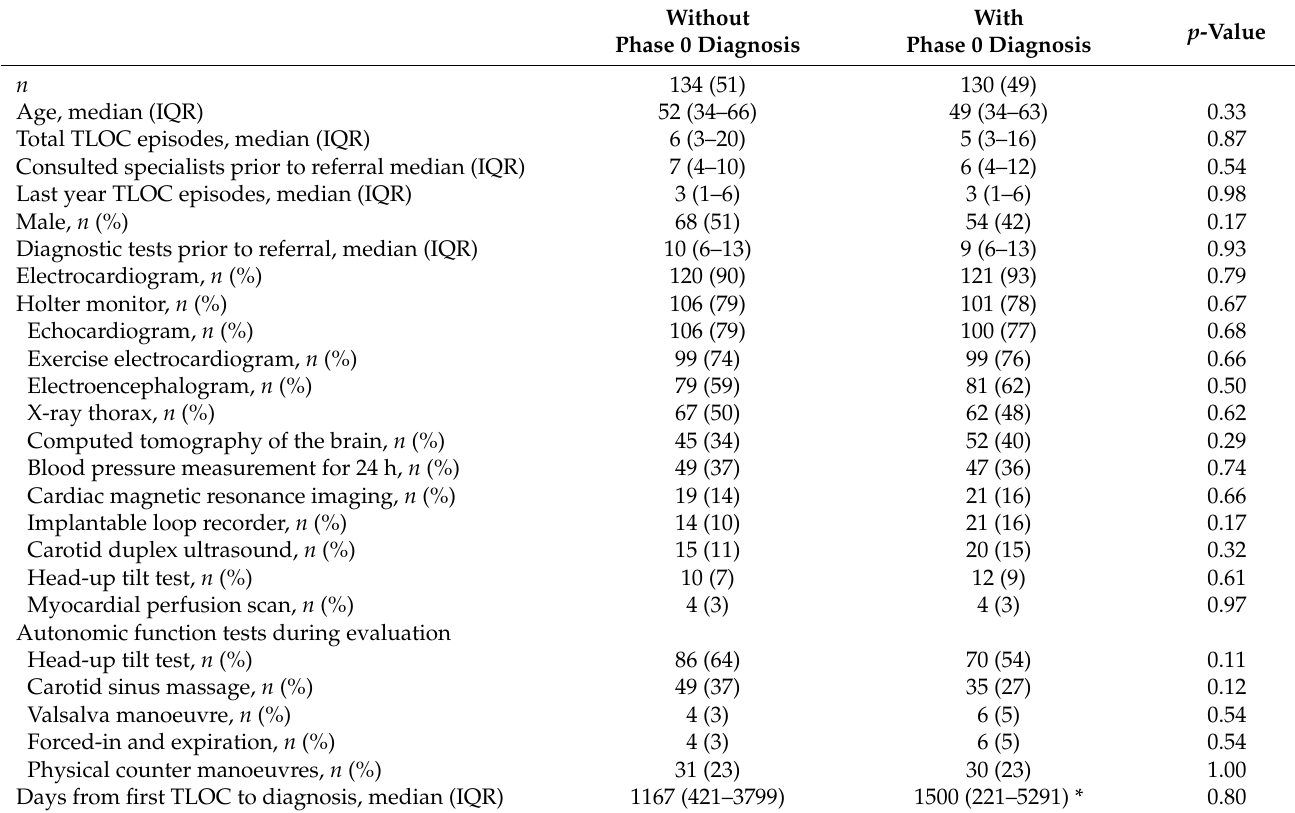
Table 2. Patient characteristics for those with phase 0 diagnosis and without phase 0 diagnosis. Phase 0 diagnosis is the referral diagnosis.